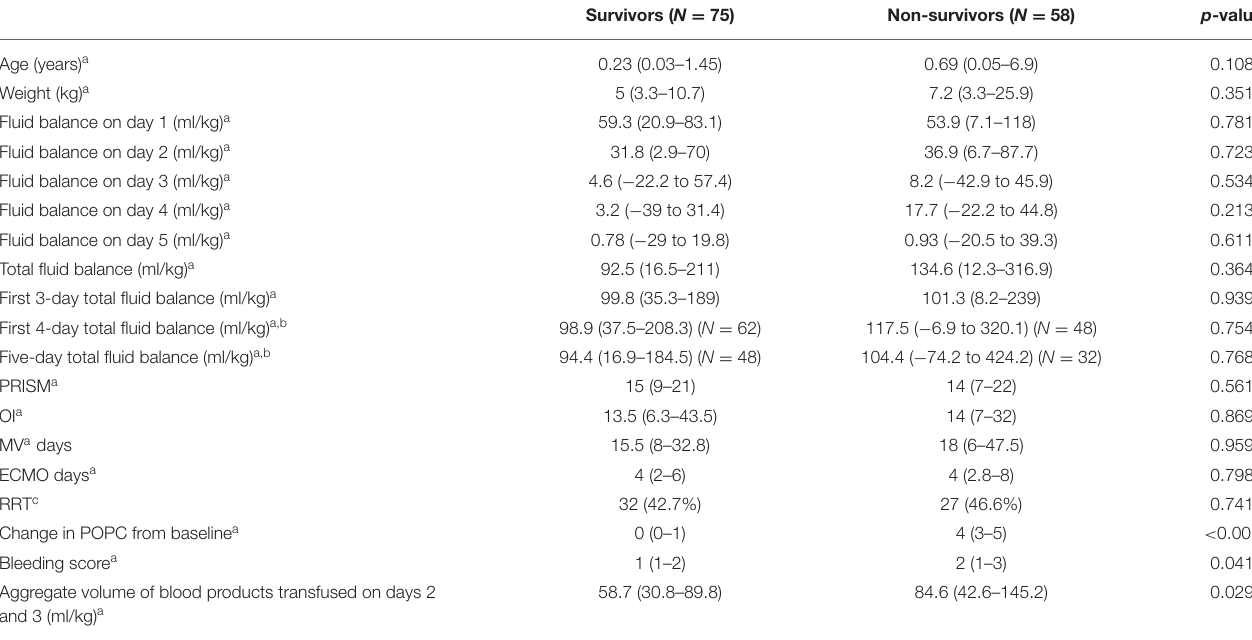
TABLE 2 | Comparison of risk factors and outcomes between survivors vs. non-survivors in the VA-ECMO (venoarterial extracorporeal membrane oxygenation)